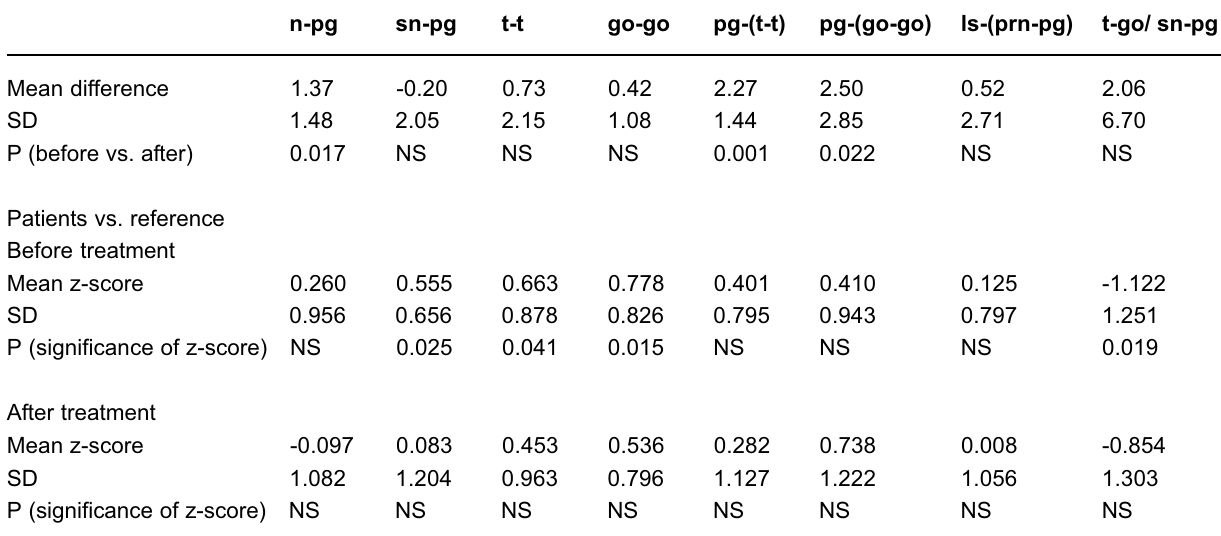
Differences are expressed in mm (distances) and % (ratio). Patients vs. reference: values are z-score units. P (before vs.